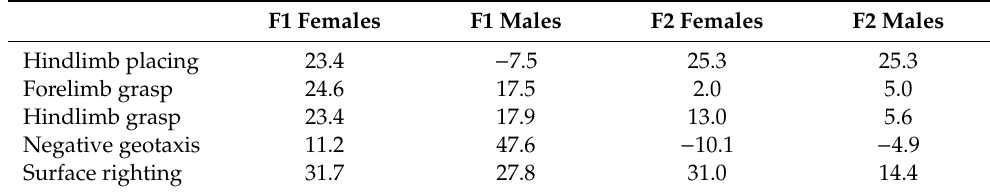
Table 3. Percentage di ff erence in the area under the curve of reflex manifestation presence of F0 dams’ o ff spring consuming advanced glycation end products rich diet versus those on the control